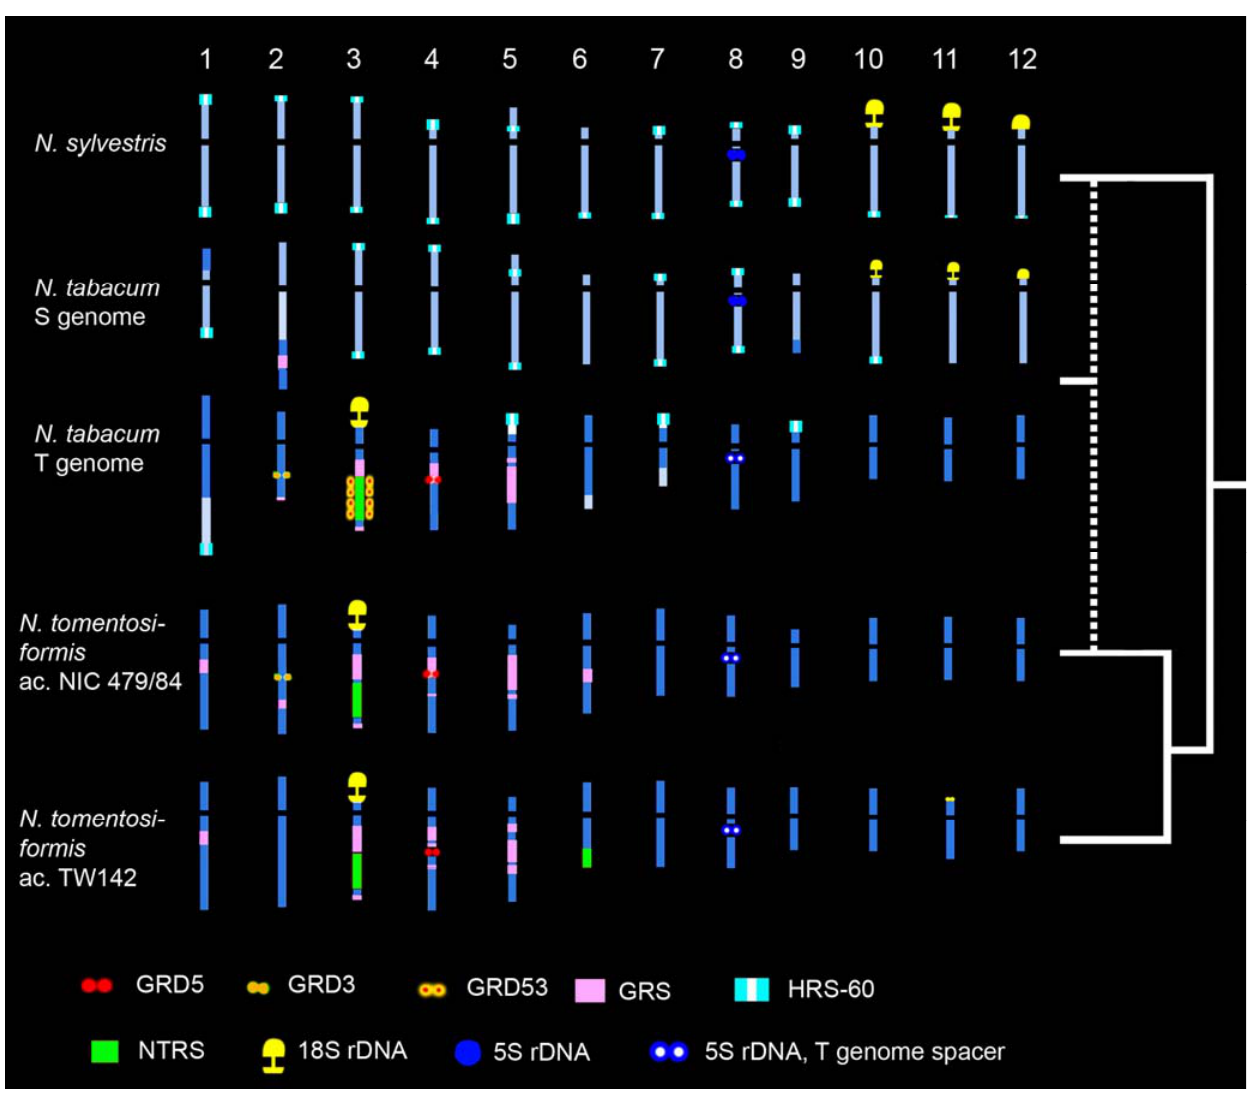
Figure 5. Idiograms for the subgenomes of Nicotiana tabacum and the extant species representing its hypothesised parental lineages. The positions of repetitive DNA clusters used for predicting genomic relationships are shown (for details see [73]). The phylogenetic scheme on the right indicates parental species divergence and the